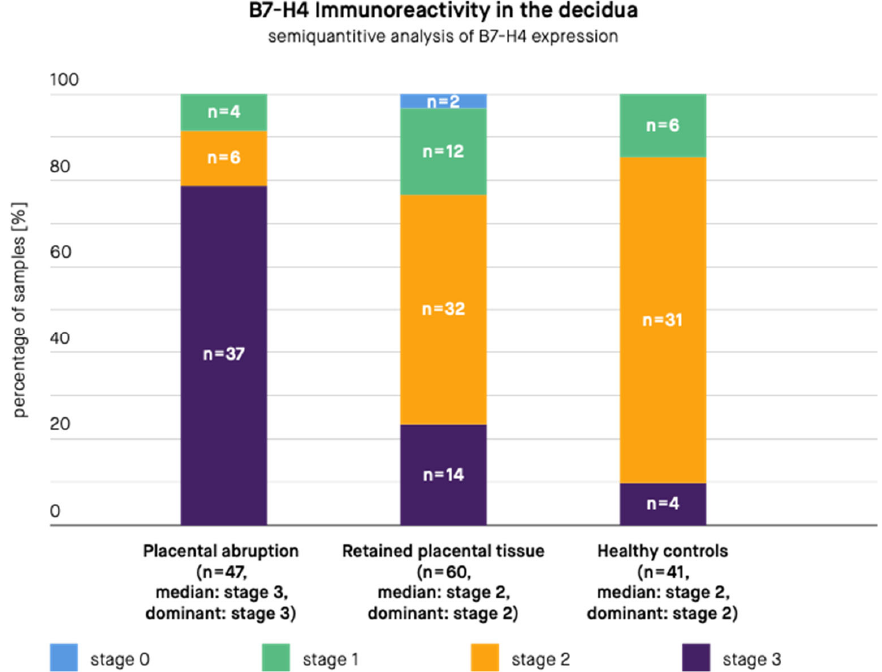
Figure 2. B7-H4 immunoreactivity in the decidua in samples from patients with placental abruption, retained placental tissue, and healthy controls. n—Number of samples.